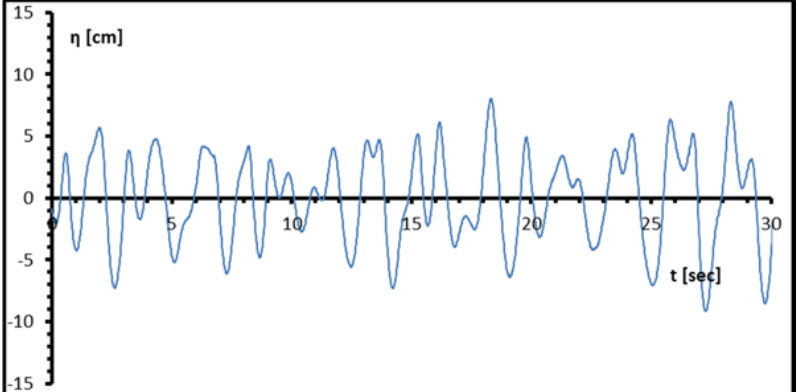
Figure 10. Water elevation η time series for Experiment #7.